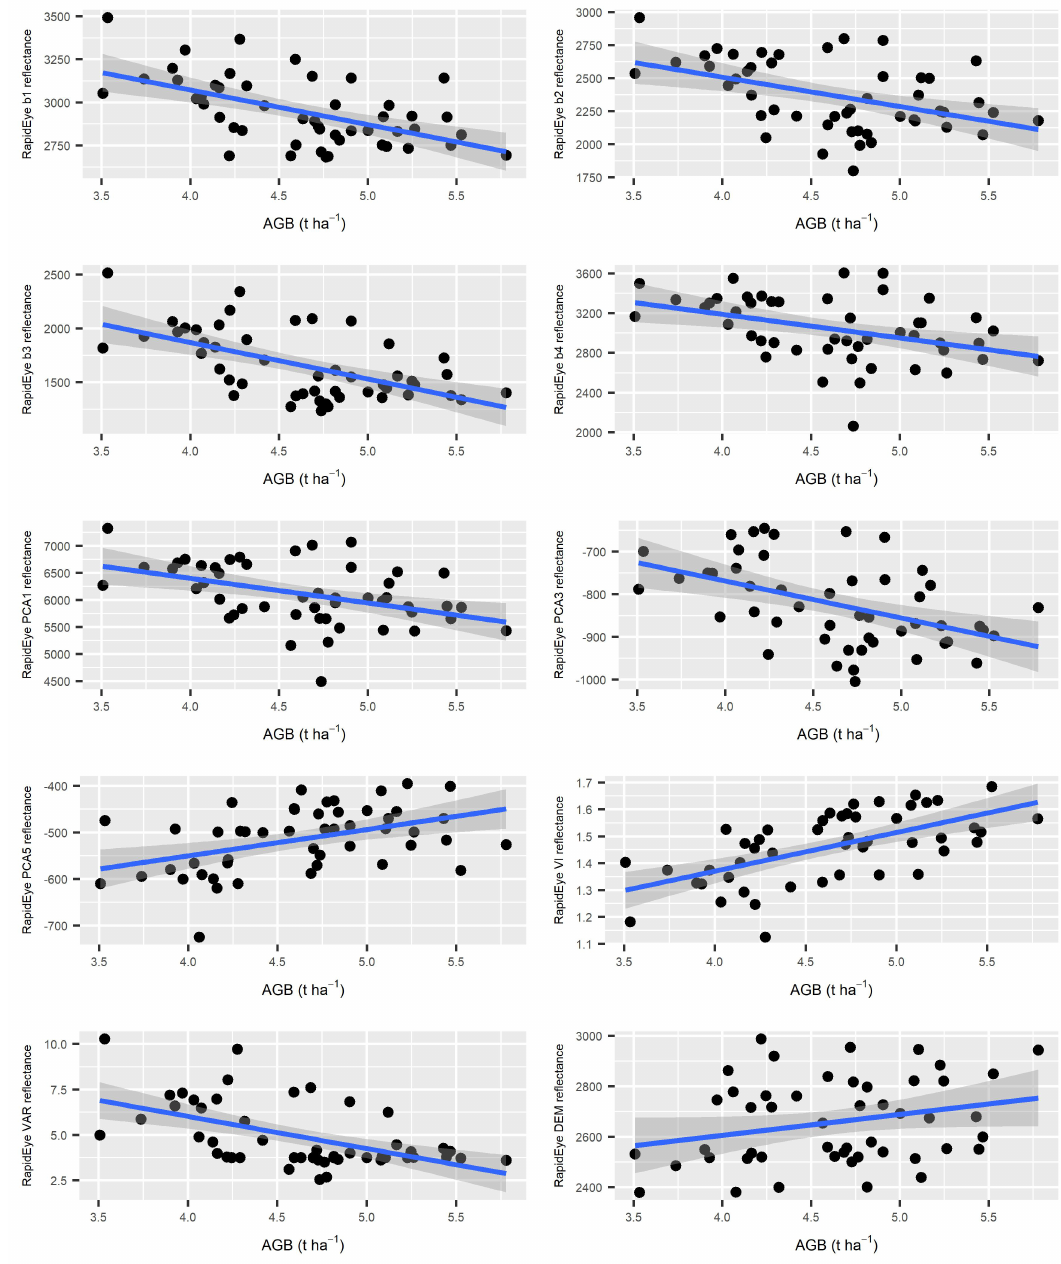
Figure 4. Correlations between variables derived from a RapidEye image and the AGB from the field